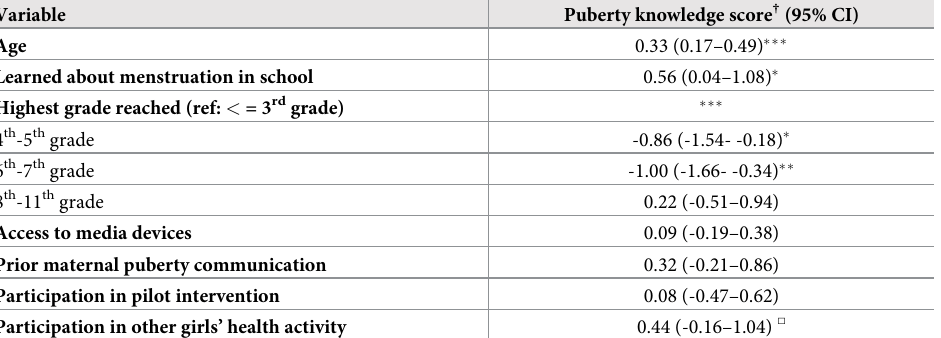
Table 5. Bivariate analysis for puberty knowledge score among girls enrolled in school who had reached menarche (N =